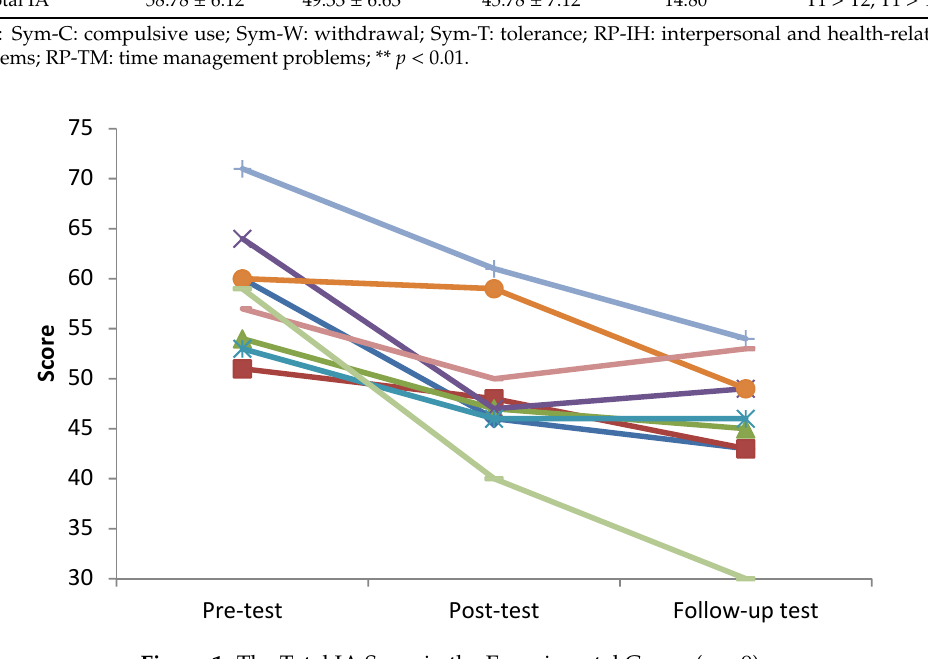
Table 3. Comparison of the Differences among Pre-test, Post-test and Tracking Scores in the Experimental Group (x ± s).